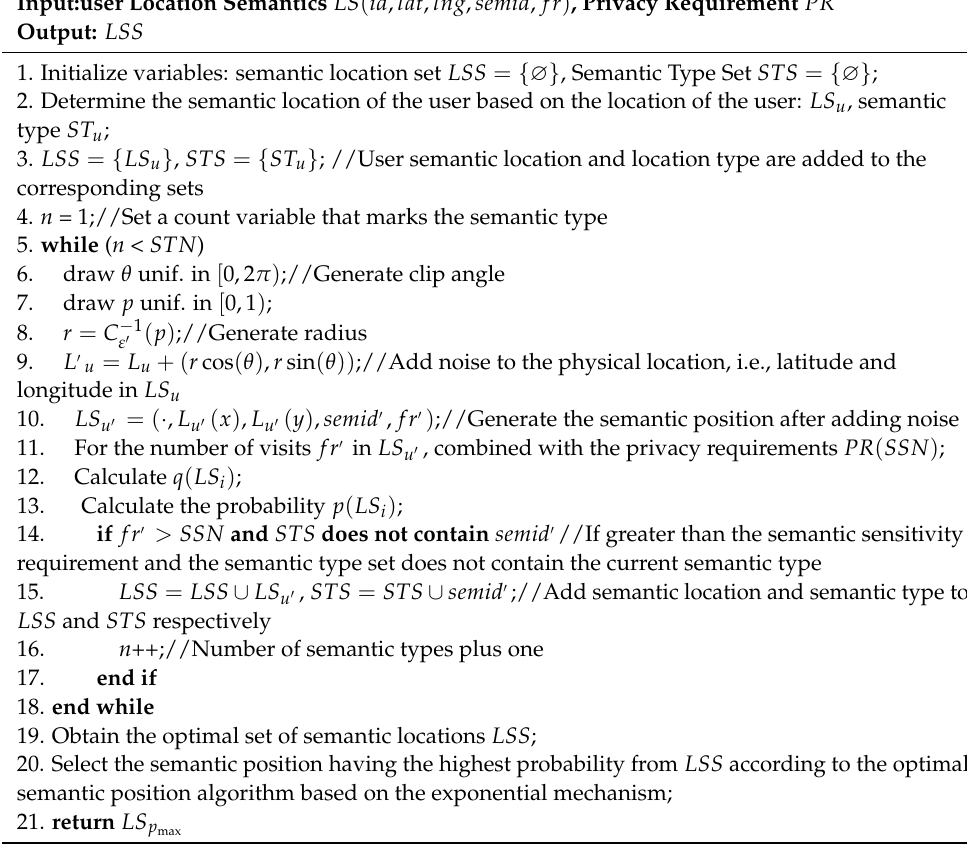
Algorithm 1. DPALS algorithm